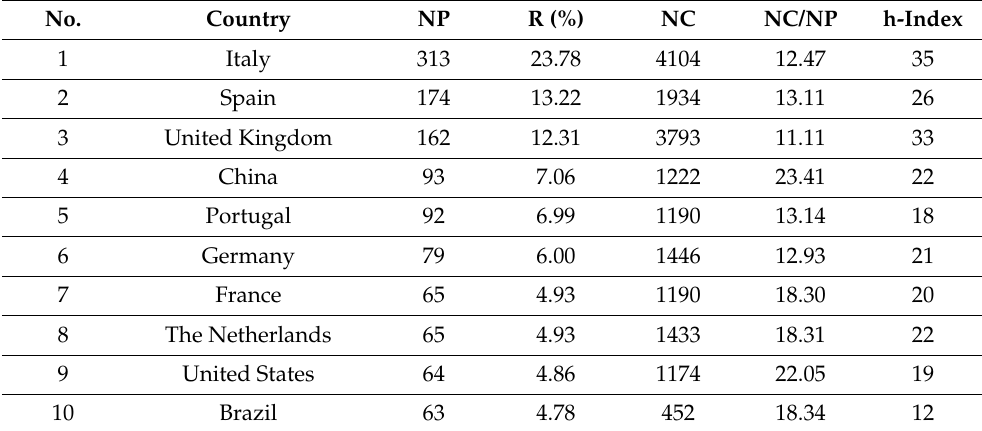
Table 2. Top 10 countries in the circular economy and food publications during